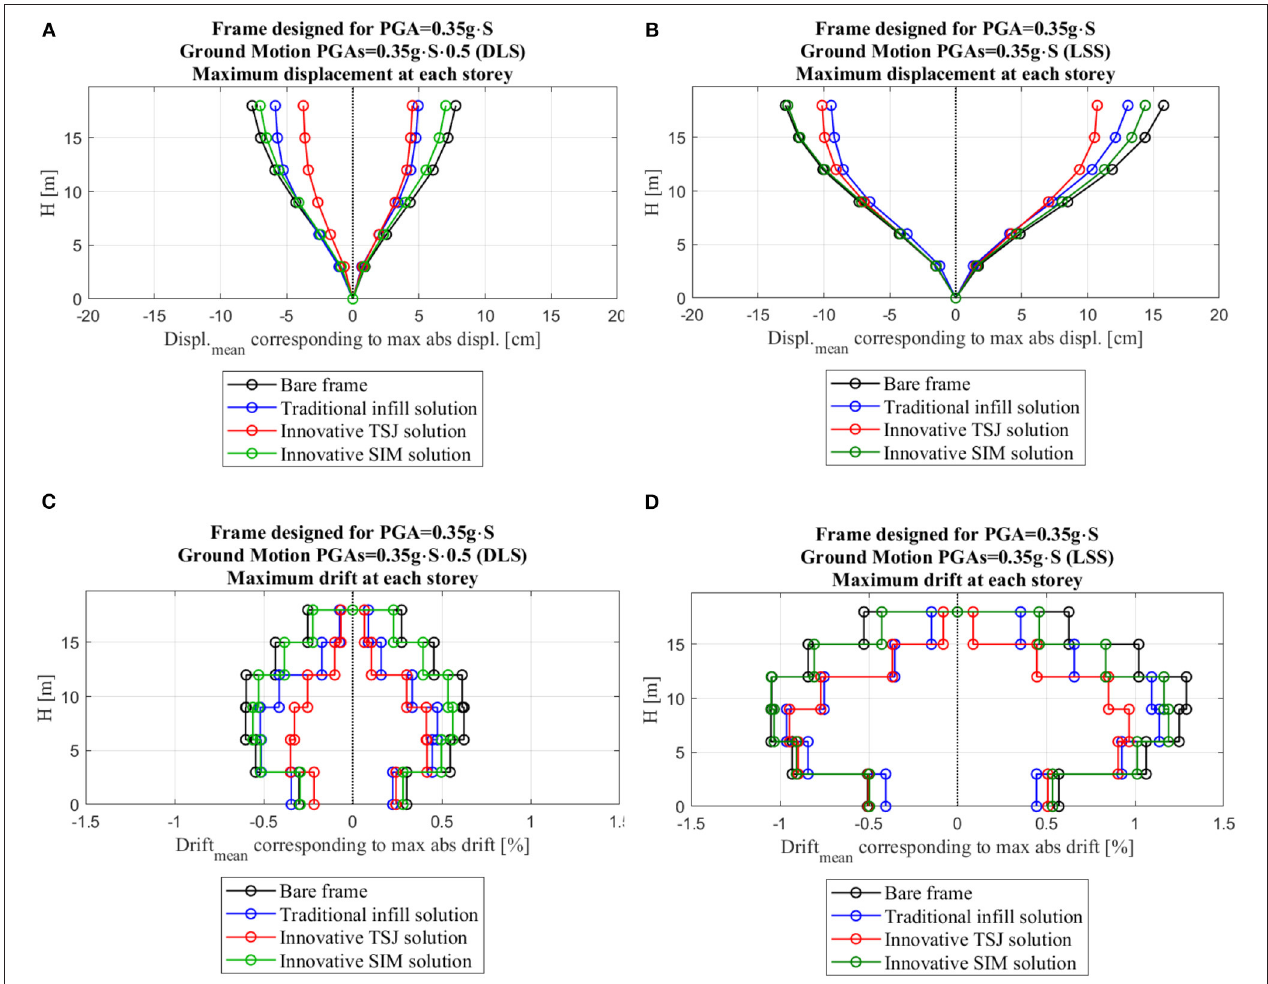
FIGURE 25 | (A) Displacement profiles at damage limit state (DLS). (B) Displacement profiles at life safety limit state (ULS/LSS). (C) Inter-story drift profiles at DLS. (D) Inter-story drift profiles at ULS/LSS.